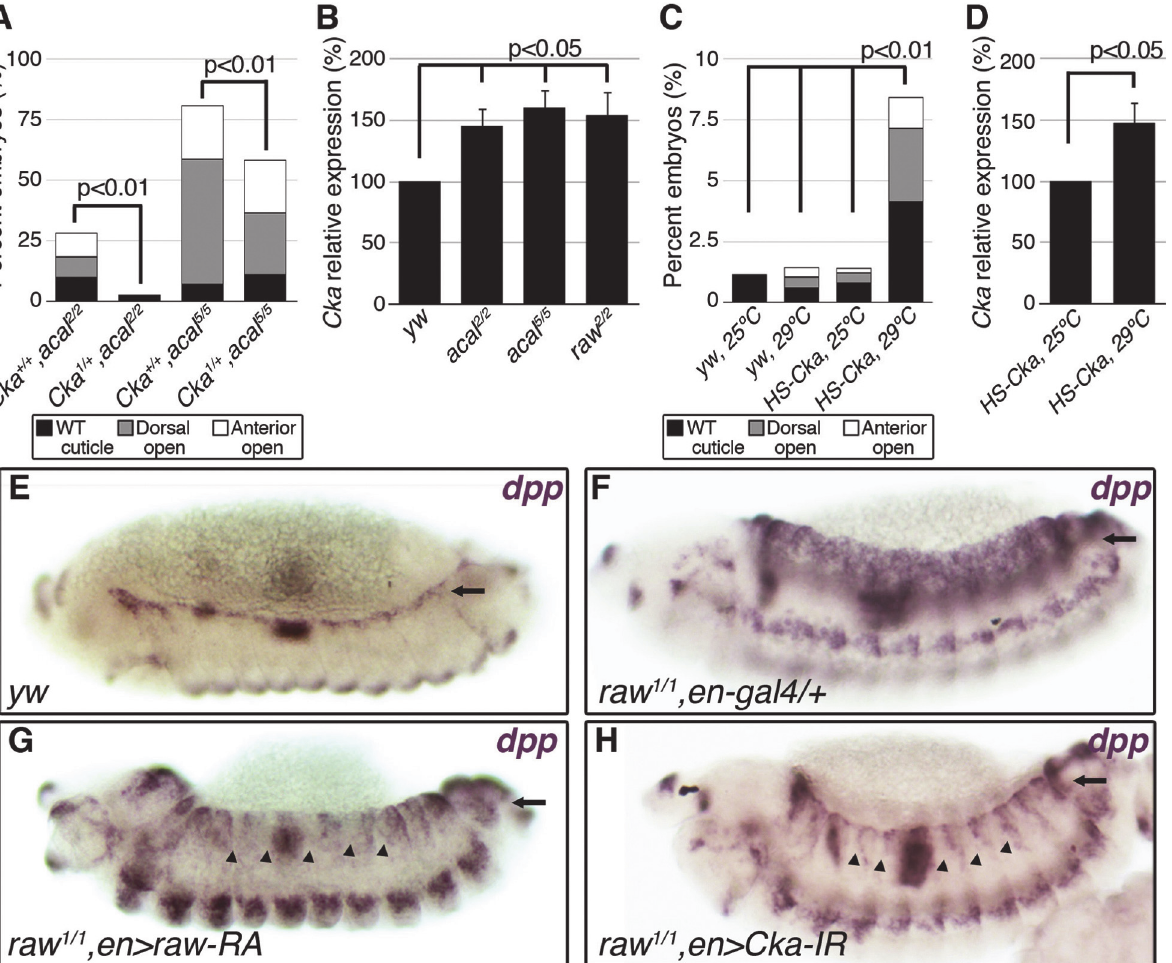
Fig 5. Cka is downstream of raw and acal . (A) Genetic interaction between Cka and acal mutants. Number of animals analyzed: Cka +/+ , acal 2/2 = 192, Cka 1/+ , acal 2/2 = 219, Cka +/+ , acal 5/5 = 391, Cka 1/+ , acal 5/5 = 171. (B) Cka relative expression in wild type and mutant embryos, as determined by qPCR. (C) Expression of a heat-shock inducible Cka transgene results in DC defects. Number of animals analyzed: yw , 25°C = 526, yw , 29°C = 591, HS-Cka , 25°C = 2006, HS-Cka , 29°C = 3227. (D) Cka expression increase due to heat shock in hs -Cka flies was confirmed by qPCR. For (A,C) embryos surviving embryogenesis represent the open space above the bar to amount to one hundred percent total of embryos analyzed. Chi square tests were used to calculate significance. For (B,D) represents the means of three independent experiments run twice +/ − SEM. Significance was assessed using Student ’ s t test. (E-H) dpp in situ hybridization experiments, showing JNK-induced dpp expression (arrows). (E) Wild type embryo. (F) raw 1/1 , en-gal4/+ control, showing dpp ectopic activation (arrow). (G) Expression of UAS-rawRA with en-gal 4 , which expresses gal 4 at posterior compartments of each segment. Arrowheads show cell-autonomous suppression of dpp ectopic expression. (H) Silencing of Cka with an RNAi construct ( UAS-Cka-IR ) under en-gal 4 also suppresses dpp ectopic expression in posterior compartments of raw 1 mutants